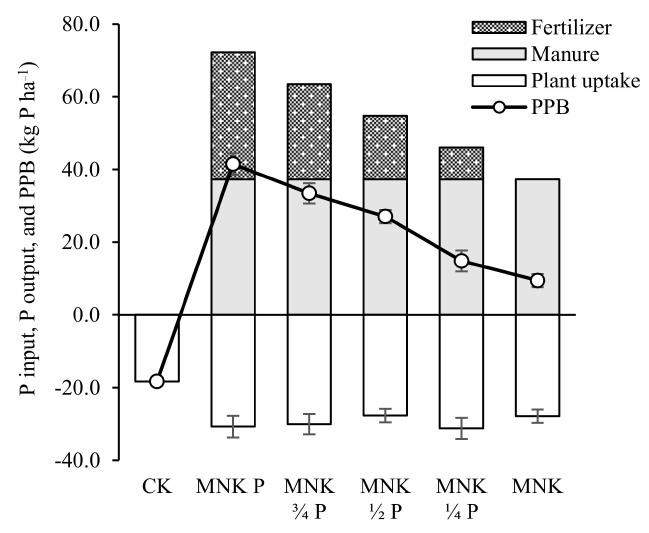
Figure 4. The annual P input from fertilizer and manure, P output through plant uptake at harvest, and partial P balance (PPB) among treatments. Bars indicate standard deviation ( n = 3).